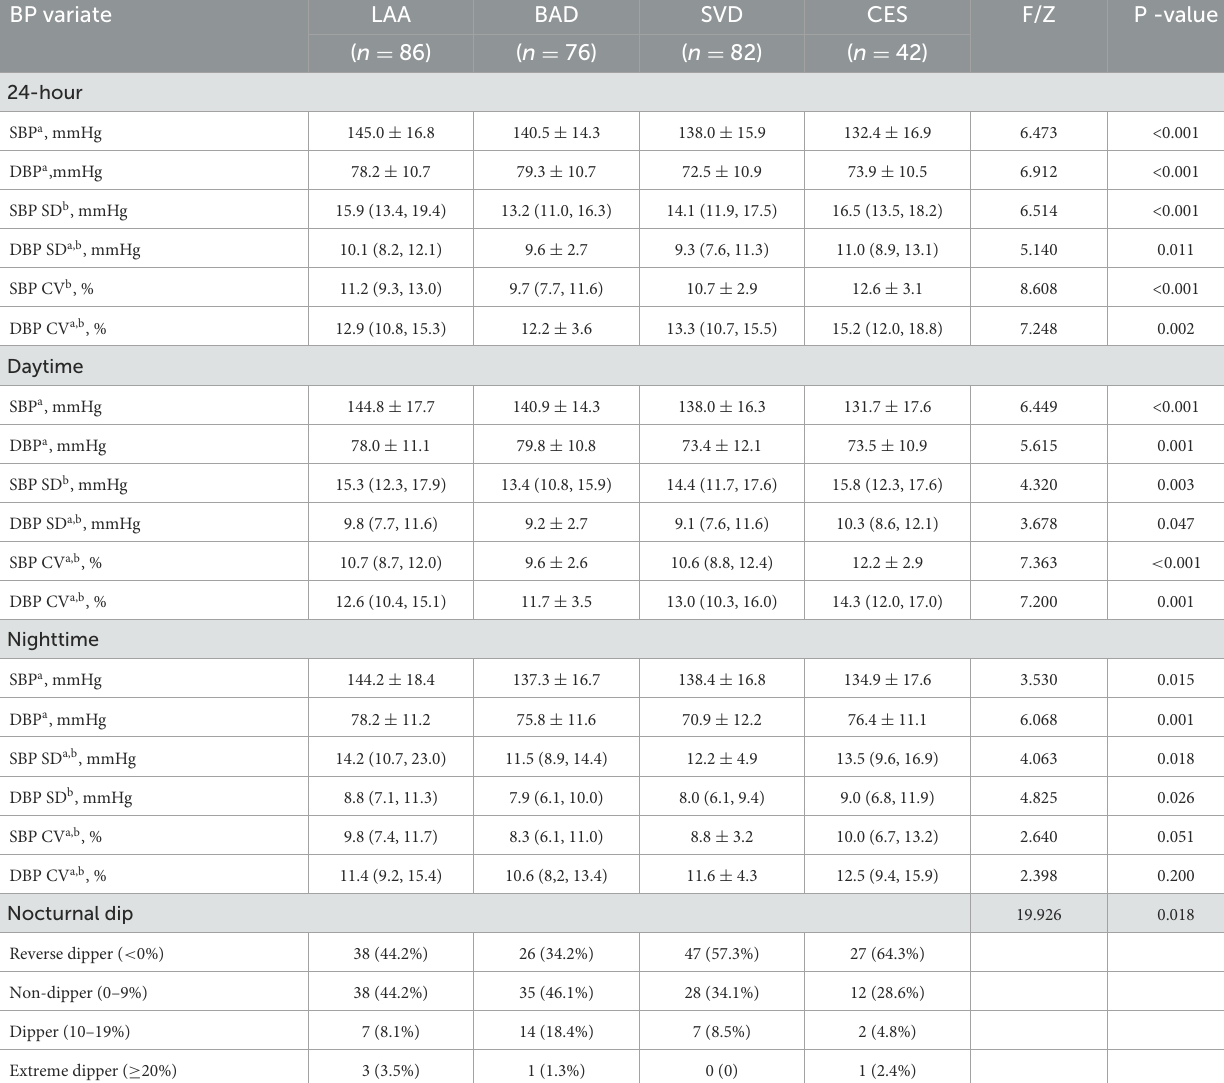
TABLE 2 Ambulatory blood pressure levels and variability in different subgroups. BP